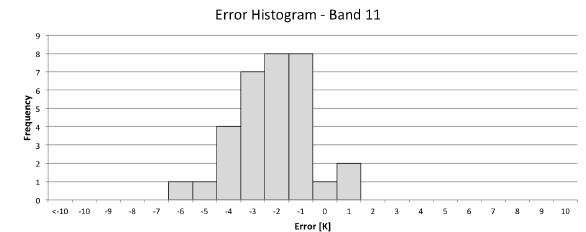
Figure 12: Histogram of error values for subset of Landsat 5 validation dataset processed using MERRA data, including only scenes with clouds in the vicinity and cloud free over the ground truth site.